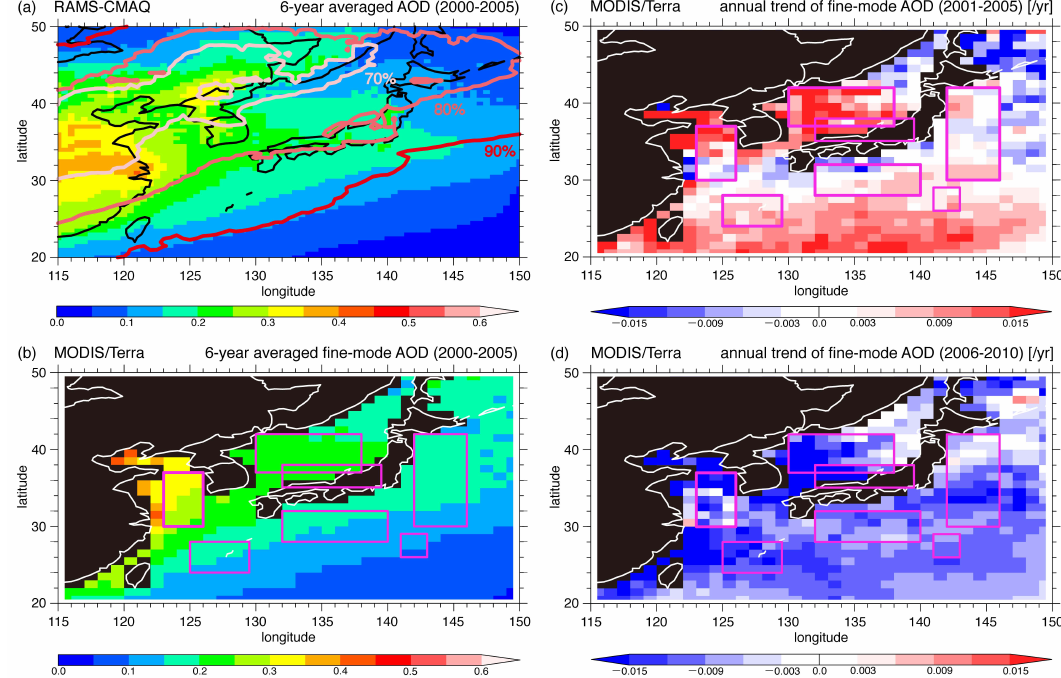
Fig. 2. (a) The 6-yr (2000–2005) averaged AODf (color) and the contribution of aerosol sulfate to AODf (contour) estimated by CMAQ model simulations; (b) the 6-yr (2000–2005) averaged AODf retrieved from MODIS/Terra; (c) the slope of the linear regression of AODf